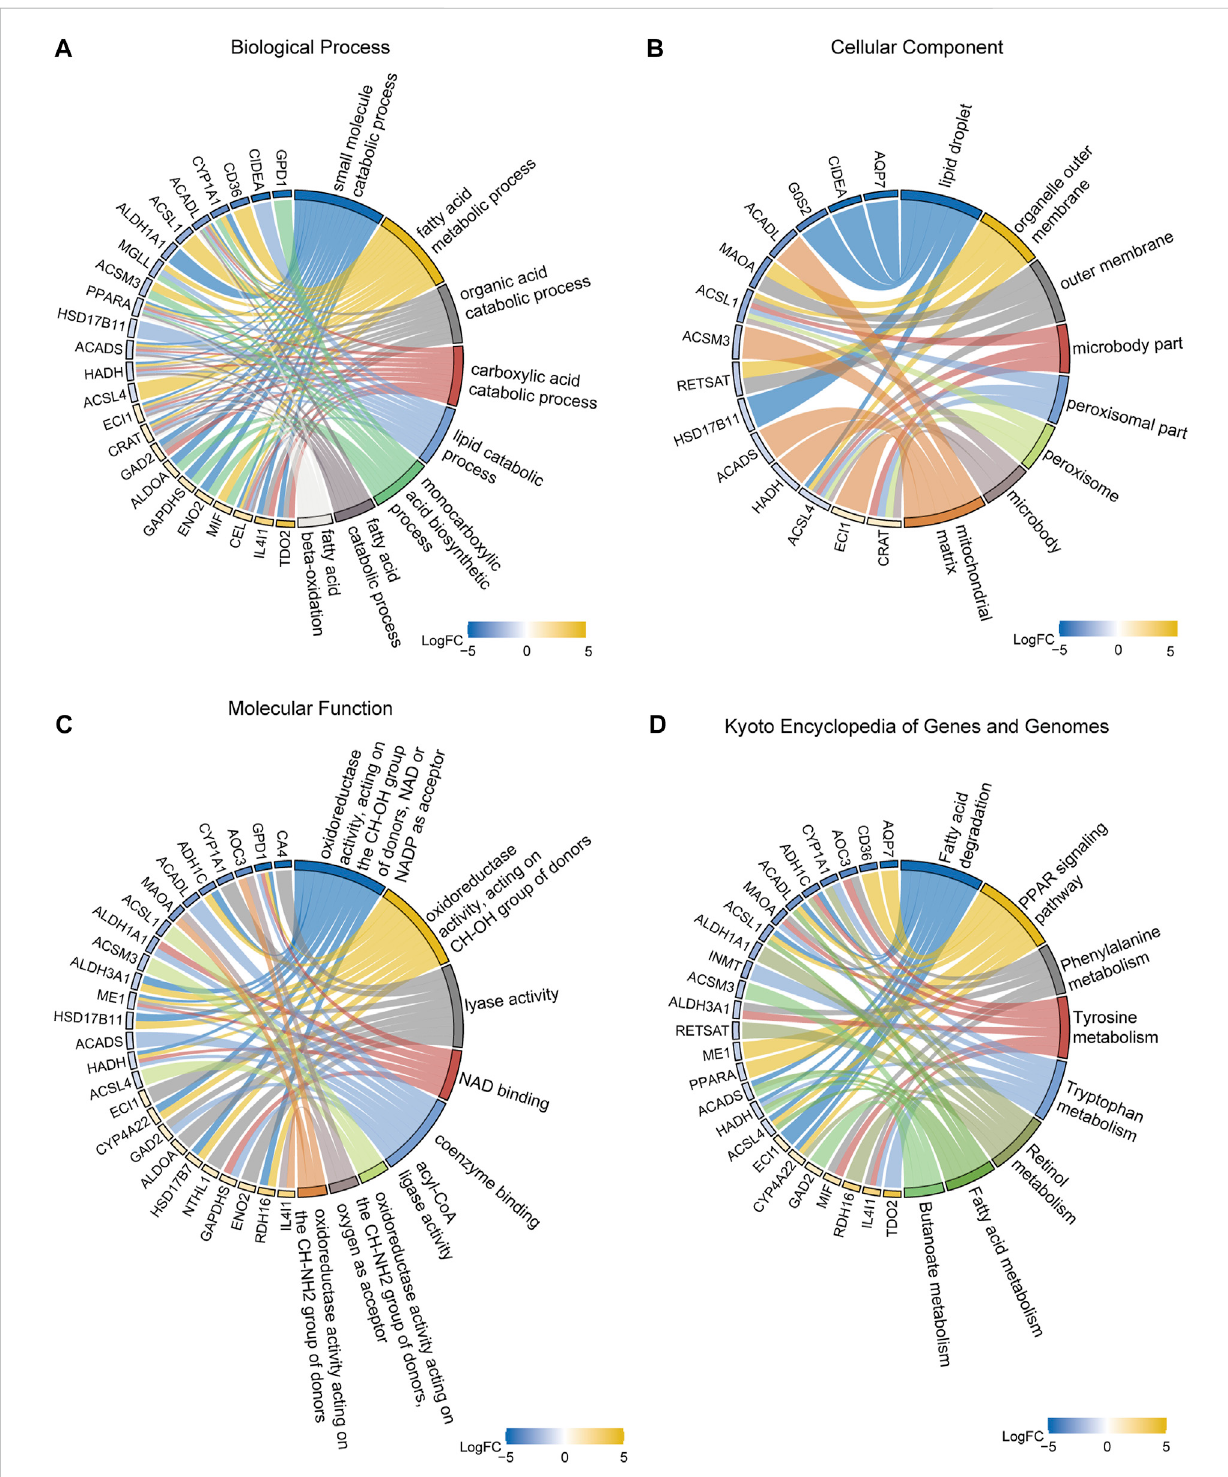
FIGURE 4 Gene ontology (GO) and Kyoto Encyclopedia of Genes and Genomes (KEGG) enrichment analyses. (A) GO biological processes. (B) GO cellular components. (C) GO molecular functions. (D) KEGG